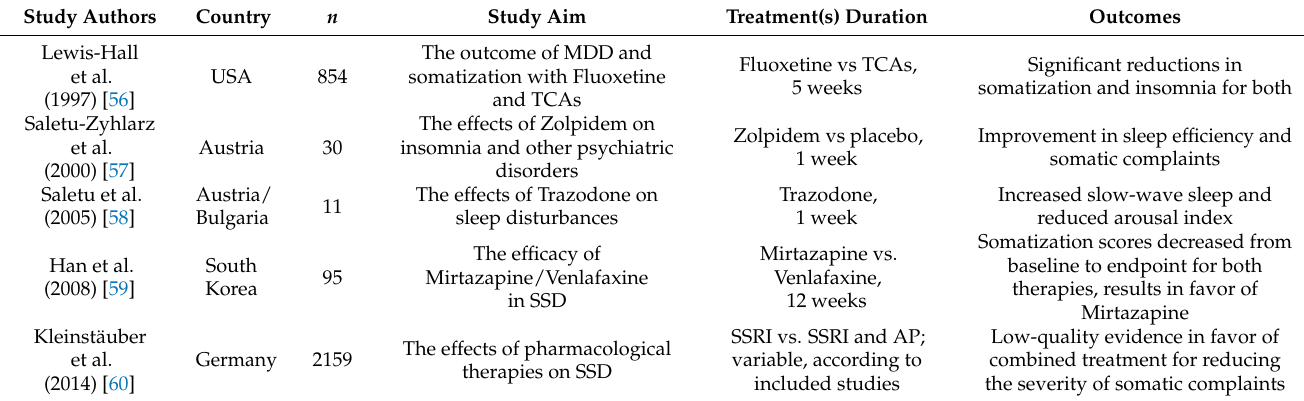
Table 3. Pharmacological treatments addressing both sleep disorders and